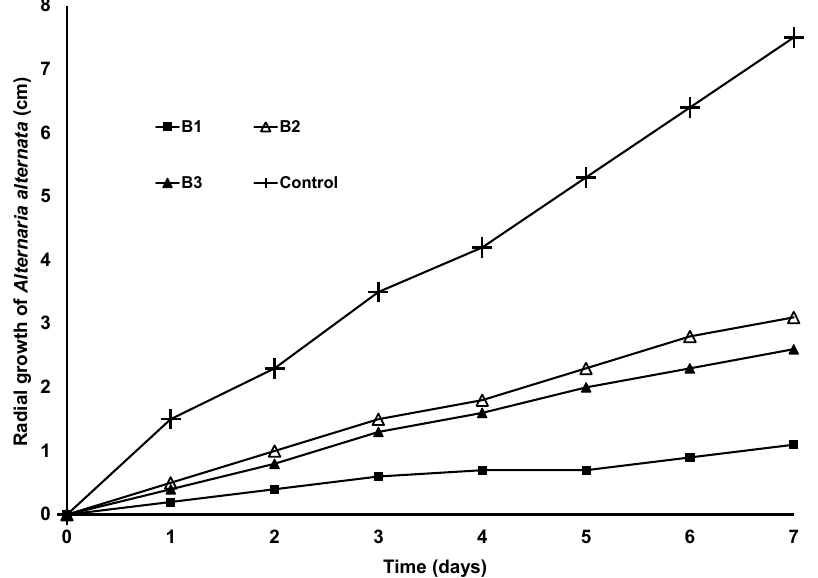
Figure 1. Antifungal effect of seven bacterial strains (B1 to B7) against C. siamense .